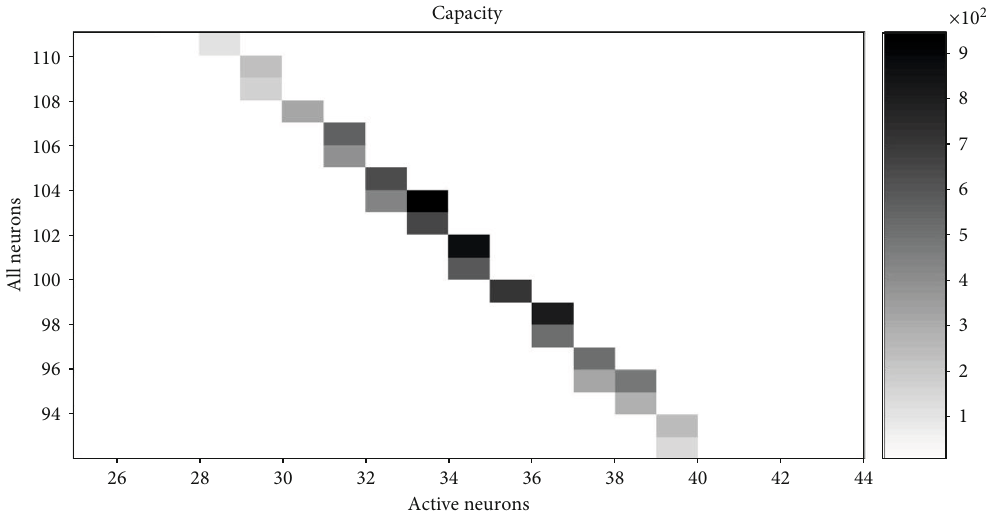
Figure 7: The representational capacity of di ff erent neural networks.